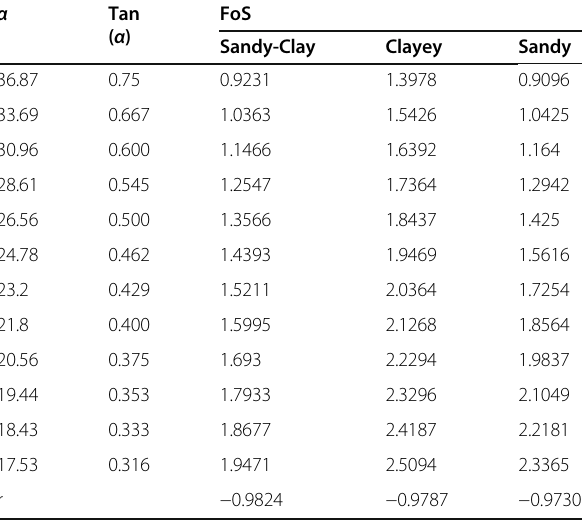
Table 5 Slope angle and factor of safety